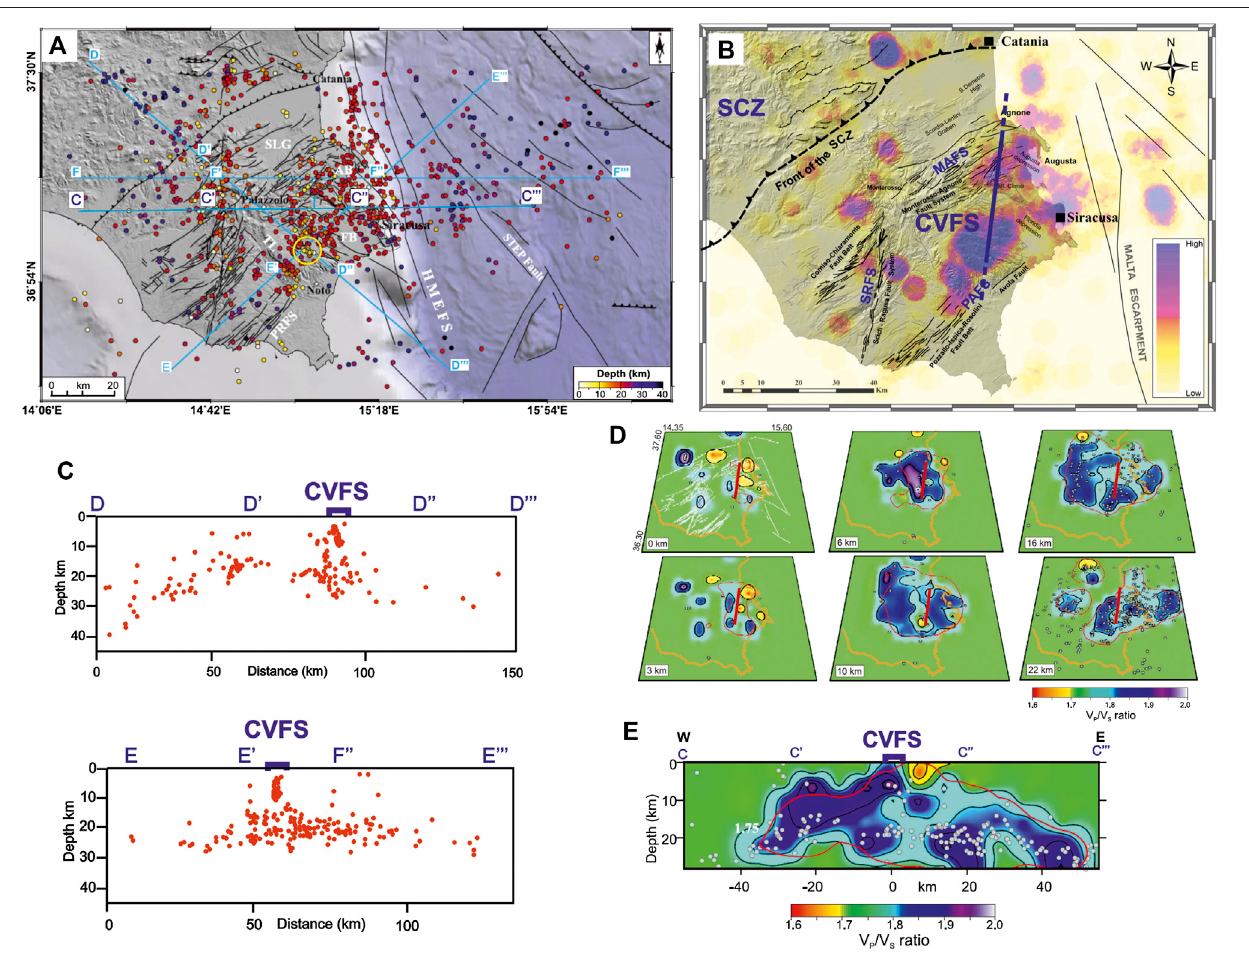
FIGURE3|(A) Seismicityduring1994 – 2013(afterMusumecietal.,2014),yellowcircleboundsthe2011 – 2012Canicattiniseismicswarms. (B) Mapofearthquake density (modi fi ed after Cultrera et al., 2015); the blue thick line shows the probable location of CVFS. (C) In-depth distribution of shocks across CVFS (modi fi ed after Musumeci et al., 2014). (D) V P /V S models for six representative layers resulting from the 3D inversion. Contour lines are spaced 0.1. Red line is the representation of CVFS. On the 0 km layer the main structural features are reported with white lines. Gray circles represent the relocated earthquakes within half the grid size of the slice;red contourlinesarethezoneswithDWSN50,seeMusumecietal.(2014)formoredetail. (E) V P /V S models,contourlinesarespaced0.1.Redcurvescontourthe zones with DWS N 50. Relocated earthquakes, within ± 10 km from the sections, are plotted as gray circles, see Musumeci et al. (2014) for more